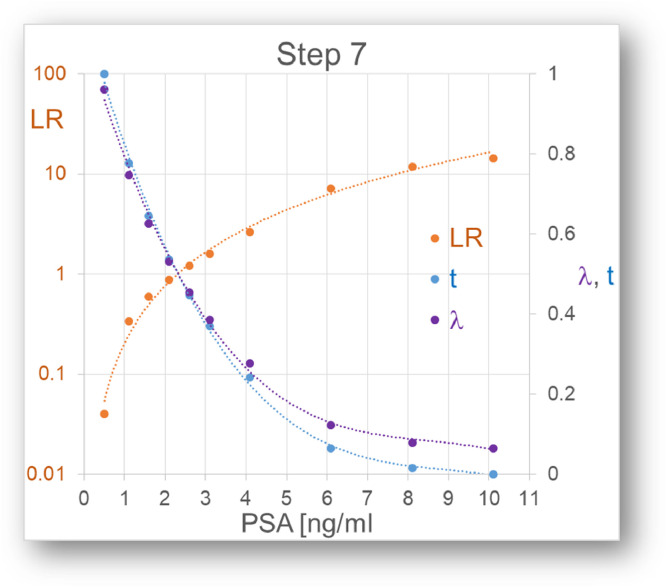
Relation between the quantitative test results and the LR(t)s. Three different calculations according to step 7.